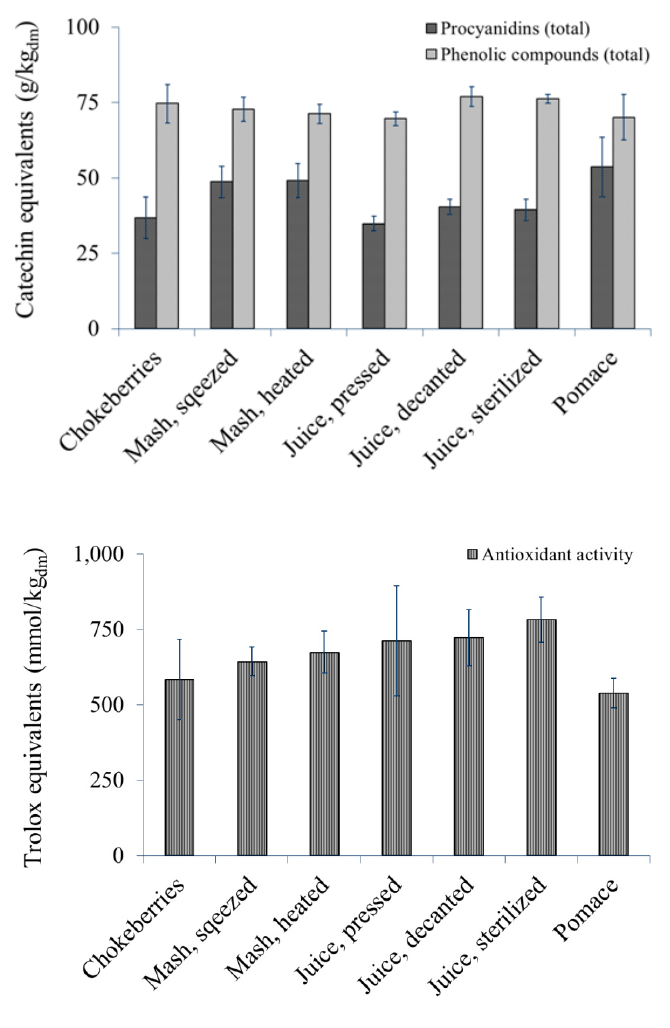
Figure 2. ( a ) Total phenolic compounds and total procyanidins contents (dry matter base: ); ( b ) antioxidant activity during the different stages of commercial juice processing g/kg dm (mean values; standard deviation; n =